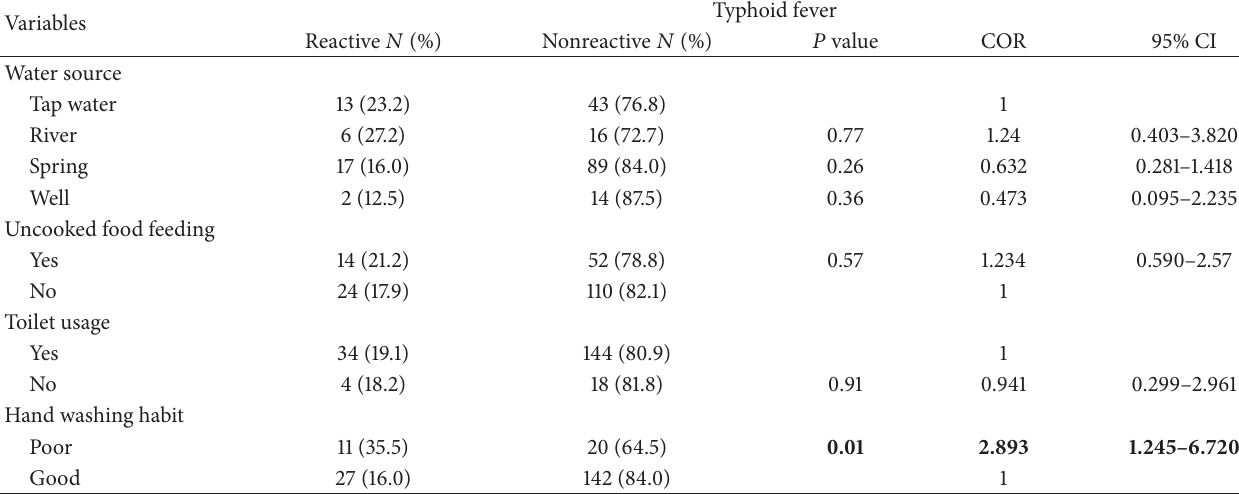
Table 6: Determinants associated with typhoid fever in febrile patients at Ayinba Health Center, Northwest Ethiopia, from April to May